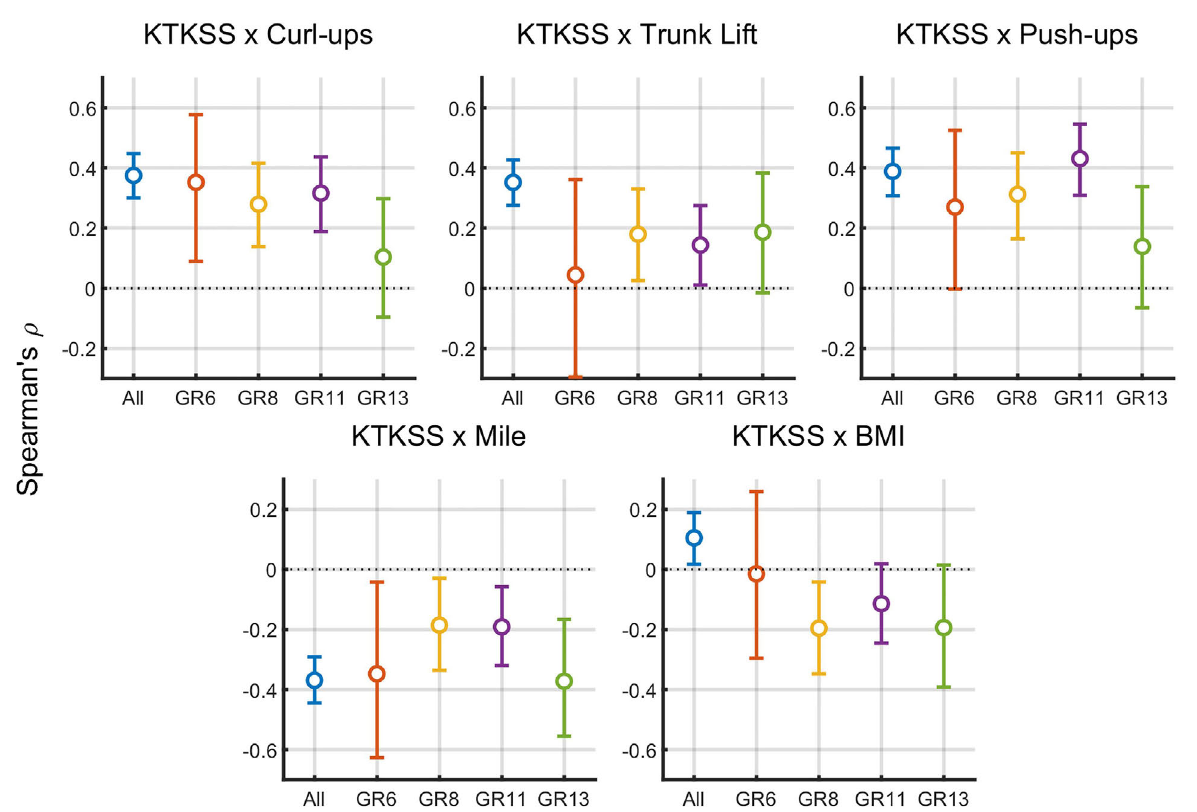
Figure 1 - Correlations (Spearman's ρ ) between the raw scores on the Fitnessgram (each graph) and the sum of raw scores of KTK (KTKSS) for each age group (partial correlation controlled by sex), and the sum of raw scores for all ages (not controlling for age and sex). The circle represents the mean and the error bars of the 95% confidence interval of the bootstrap distribution after 10000 iterations.